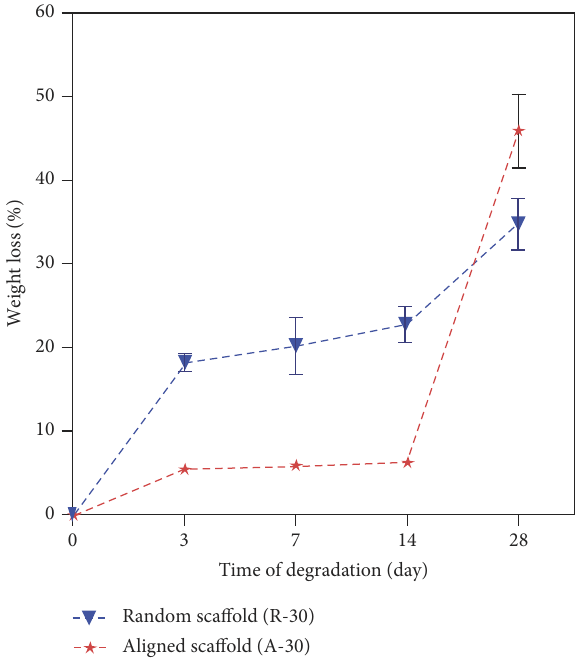
Figure 6: Weight loss percentage curves of the scafolds after 28days of immersion in the PBS solution.